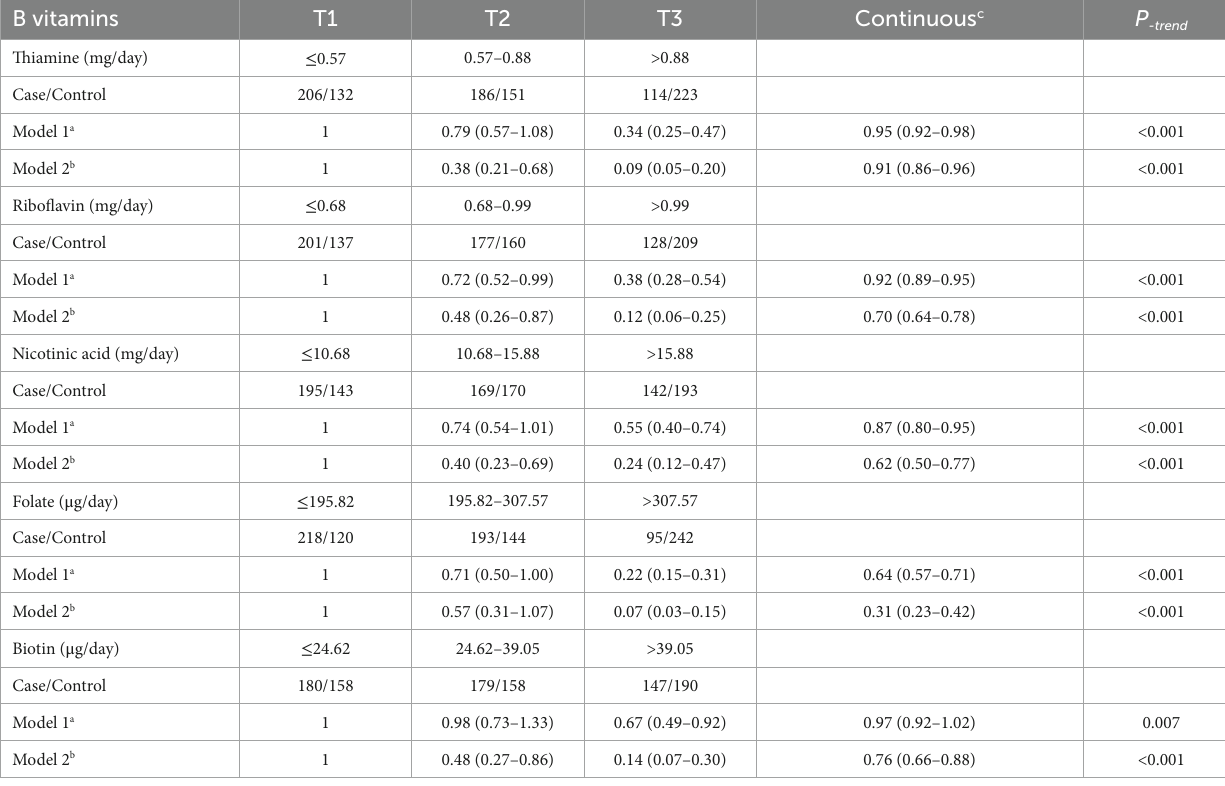
TABLE 2 Adjusted ORs and 95% CIs for the association between B vitamins and